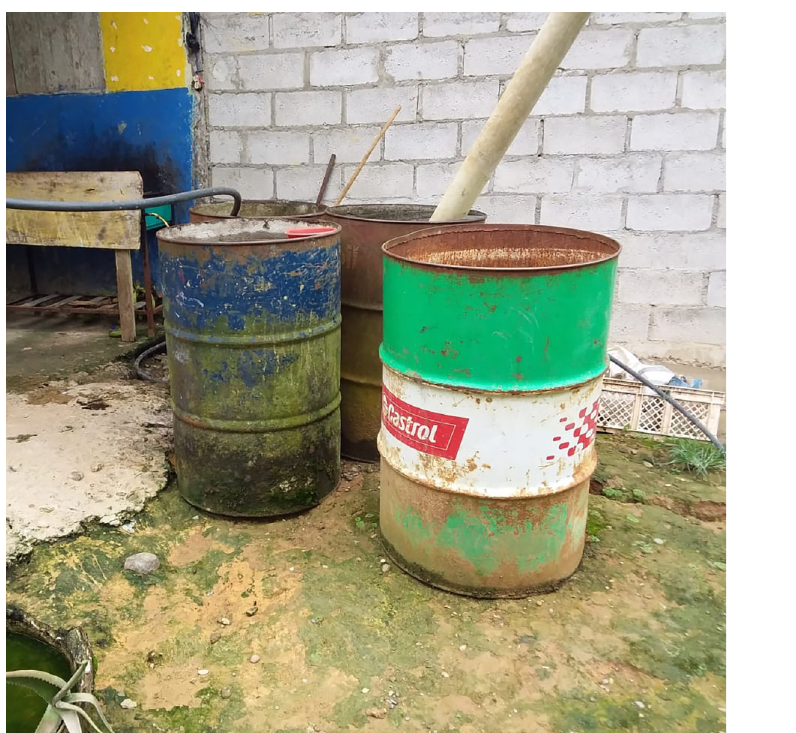
Fig 4. Outdoor rain barrels: A photo of an outdoor rain